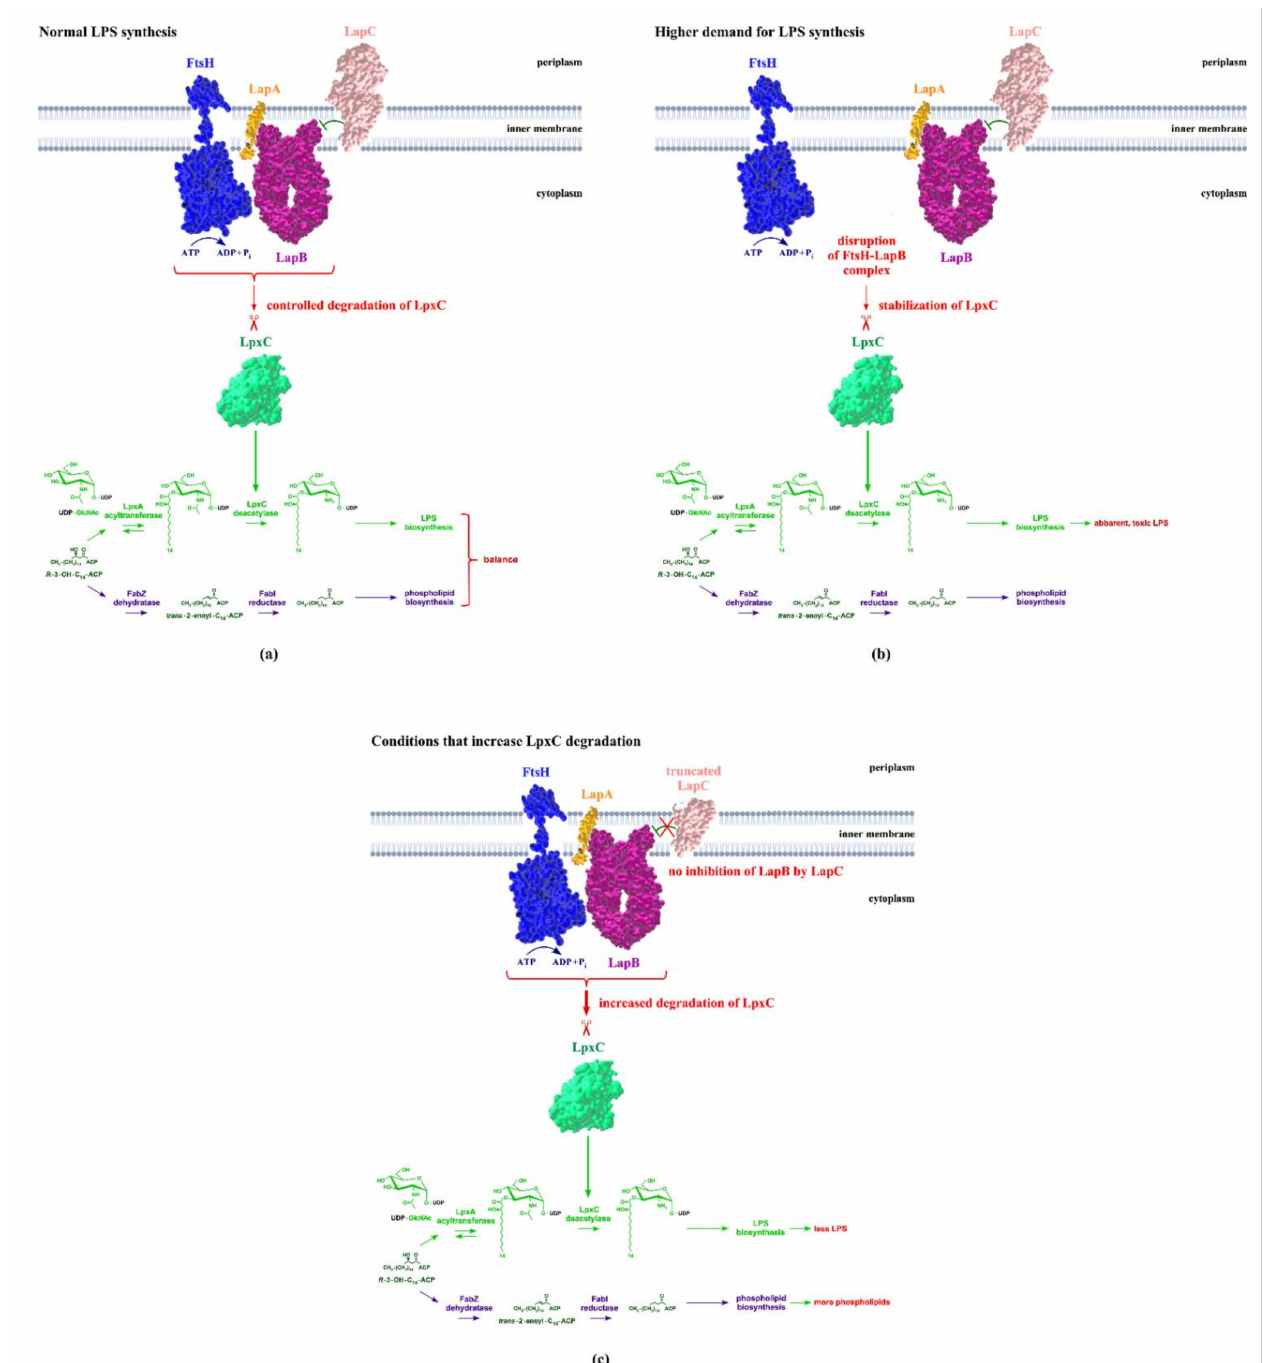
Figure 3. Model of LapC-mediated control of LpxC degradation as a function of the demand for LPS synthesis. ( a ) Under normal-growth conditions, LpxC and FabZ activity is coupled, maintaining a balanced synthesis of LPS vs. phospholipids. ( b ) When the demand for LPS synthesis is high, such as under fast-growing conditions, LapC inhibits and traps LapB preventing the LapB–FtsH complex formation and hence preventing excessive degradation of LpxC. ( c ) When the LapC periplasmic domain is absent, the LapB–FtsH complex is hyperactive, leading to increased degradation of LpxC. Similarly, when the demand for LPS is less, such as under slow-growth conditions or in the stationary phase, LPS accumulates in the periplasm, leading to increased destabilization of LpxC, with LapC not inhibiting LapB